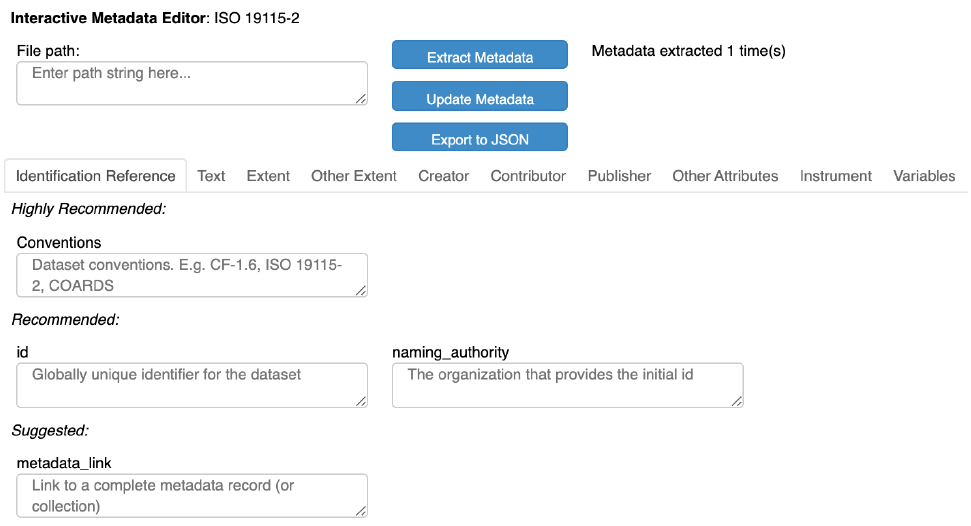
Figure 9. Interactive ISO 19115-2:2019 metadata widget.